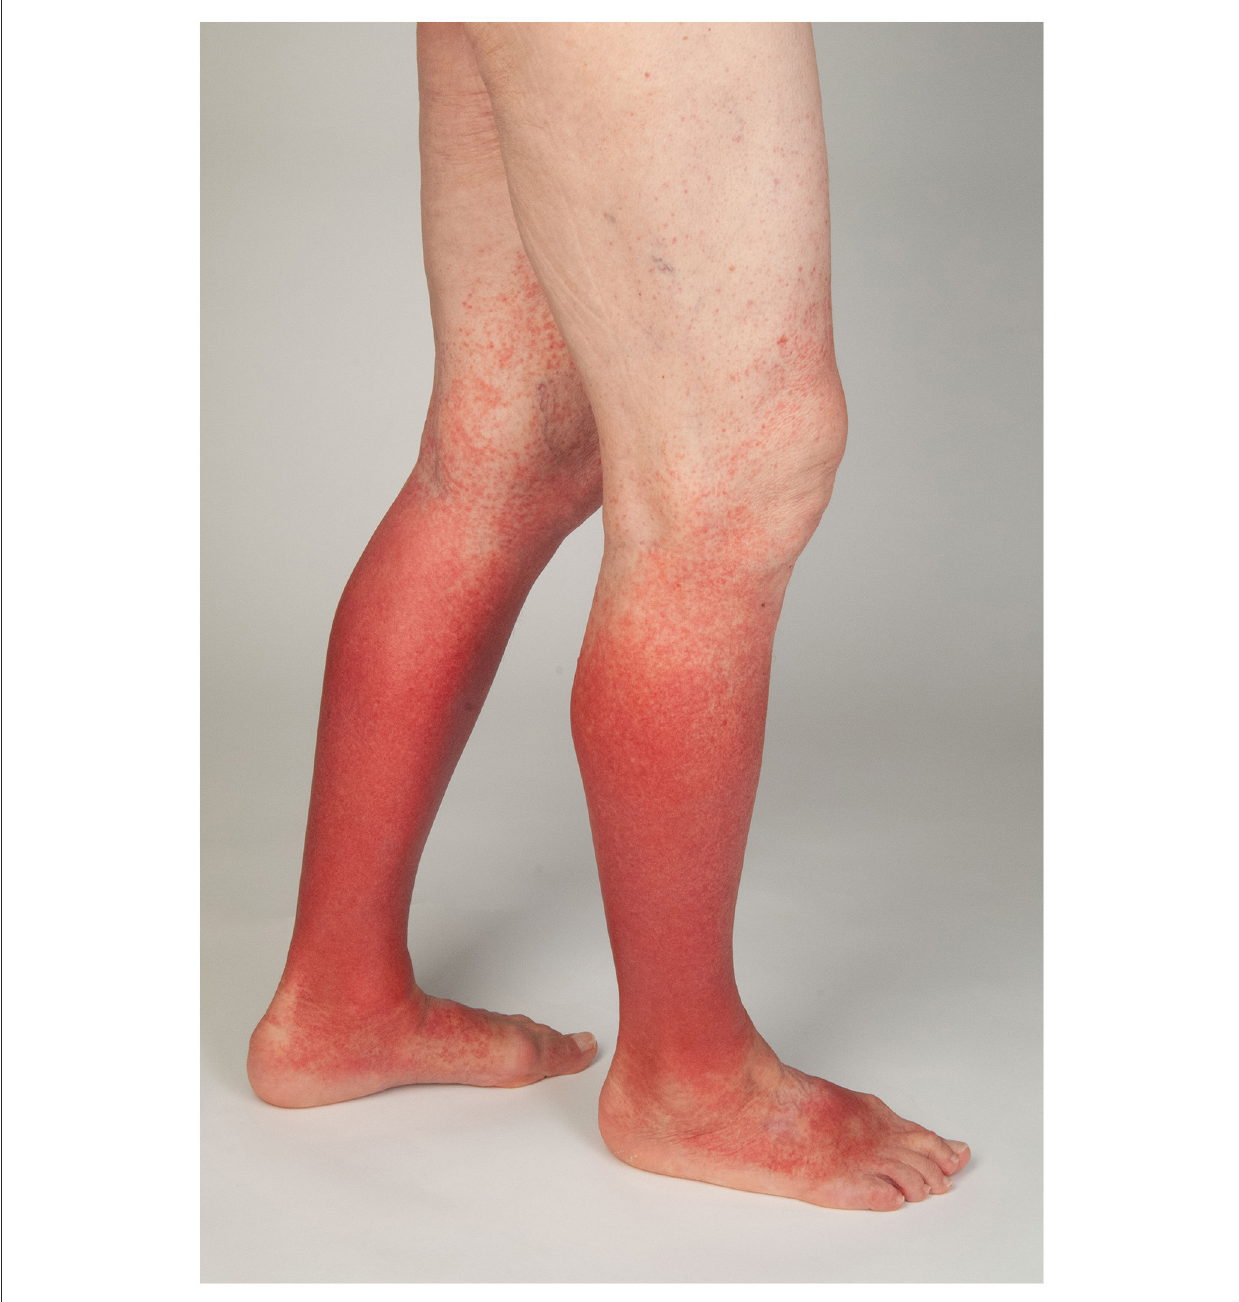
FIGURE2 Cutaneous hypocomplementemic IgG/IgM-vasculitis.